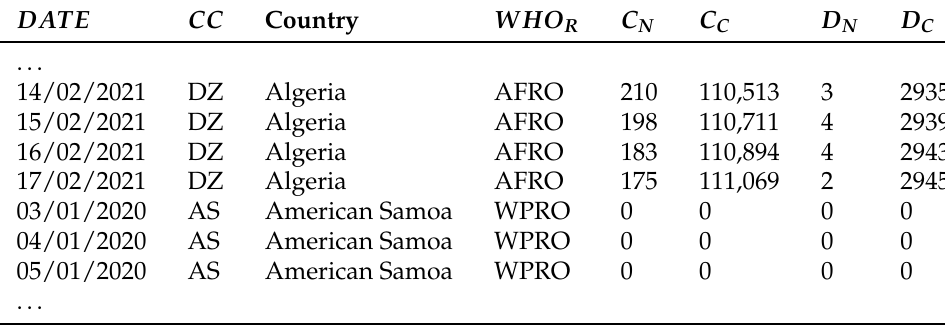
Table 2. The appearance of data in the official WHO